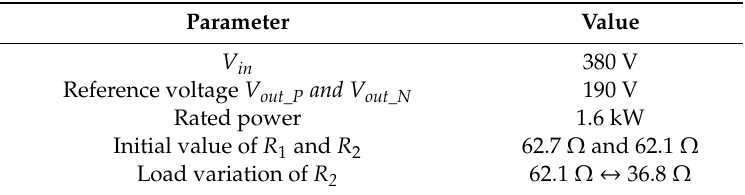
Table 4. Experimental parameters.